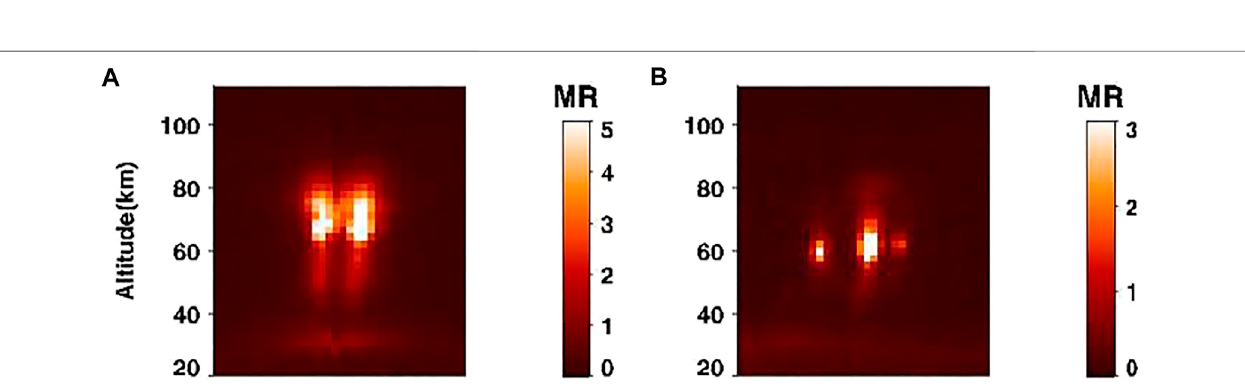
FIGURE 9 | Successive sprite events at 22:01:23.178 (UT) from August 3, 2007, demonstrating the effects of AP-measured emission ratios for (A) a pre-existing sprite and, (B) a later-occurring sprite, which are also called dancing sprites.